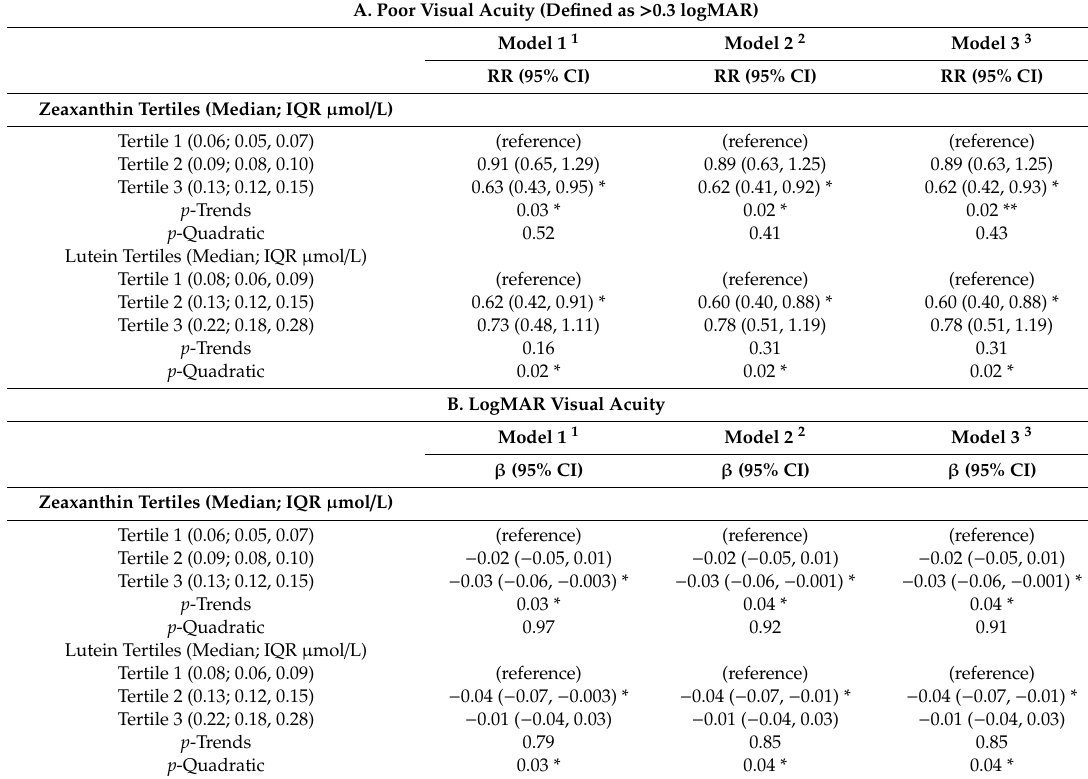
Table 2. Associations of maternal lutein and zeaxanthin with poor visual acuity ( A ) and logMAR visual acuity ( B ) in GUSTO children ( n = 471).